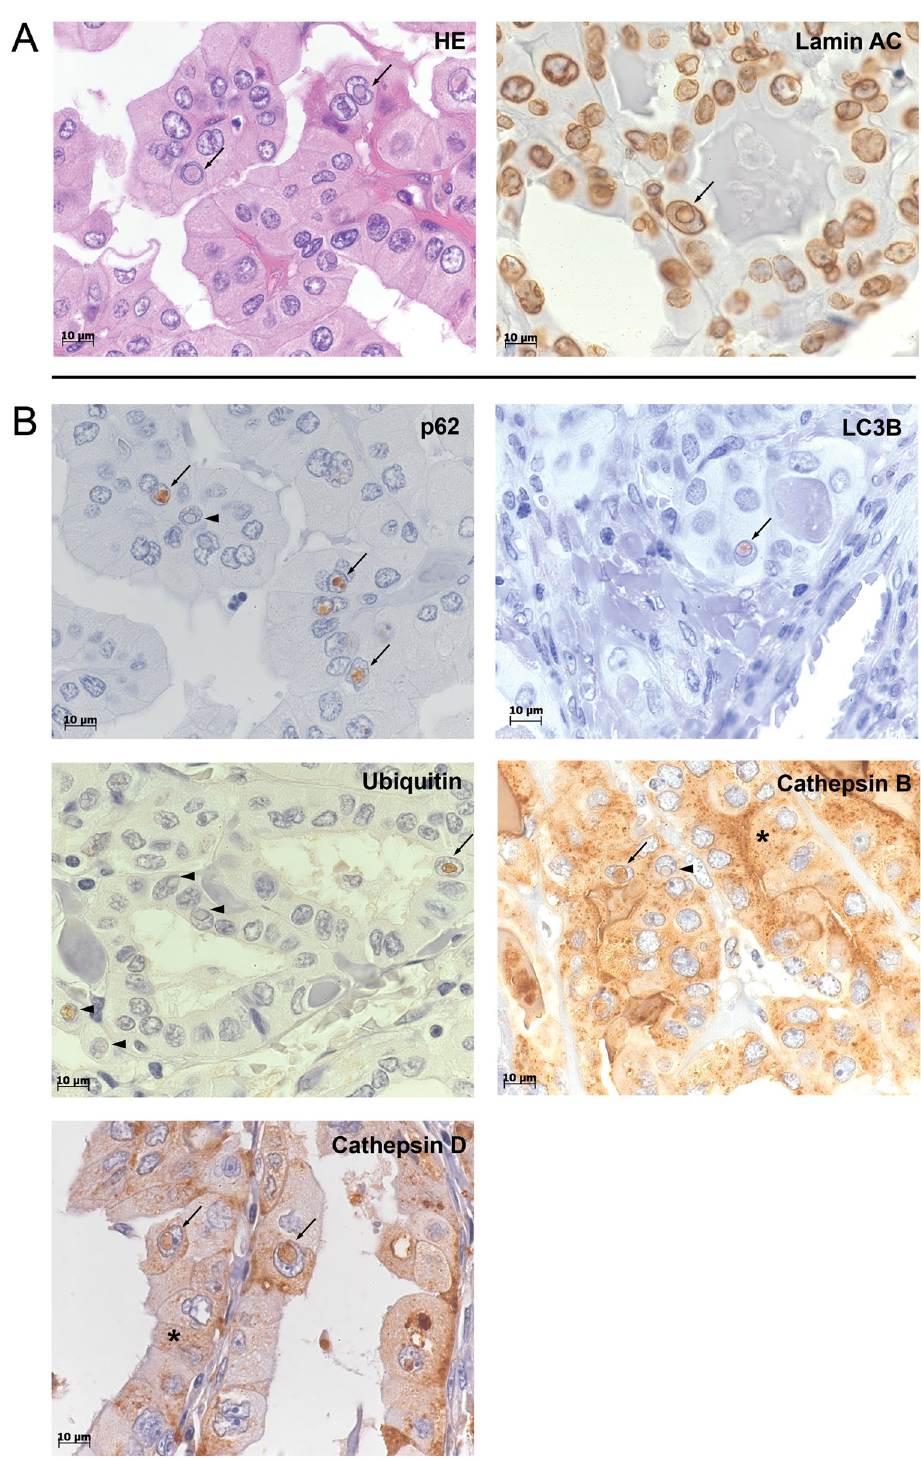
Fig 1. Intranuclear inclusions in thyroid carcinoma (TC). (A) Characterization of intranuclear inclusions (NI). Images show NI in representative cases of our TC cohort. HE-staining (left image) demonstrates that NI (arrows) are completely closed with no contact to the cytoplasm on this plane; positive lamin AC immunostaining (right image) of the limiting membrane of the inclusion (arrow) reveals its nuclear membrane origin. ( B ) Positive immunoreactivity for autophagy-associated proteins in NI. Immunohistochemistry (IHC) shows NI with varying degrees of